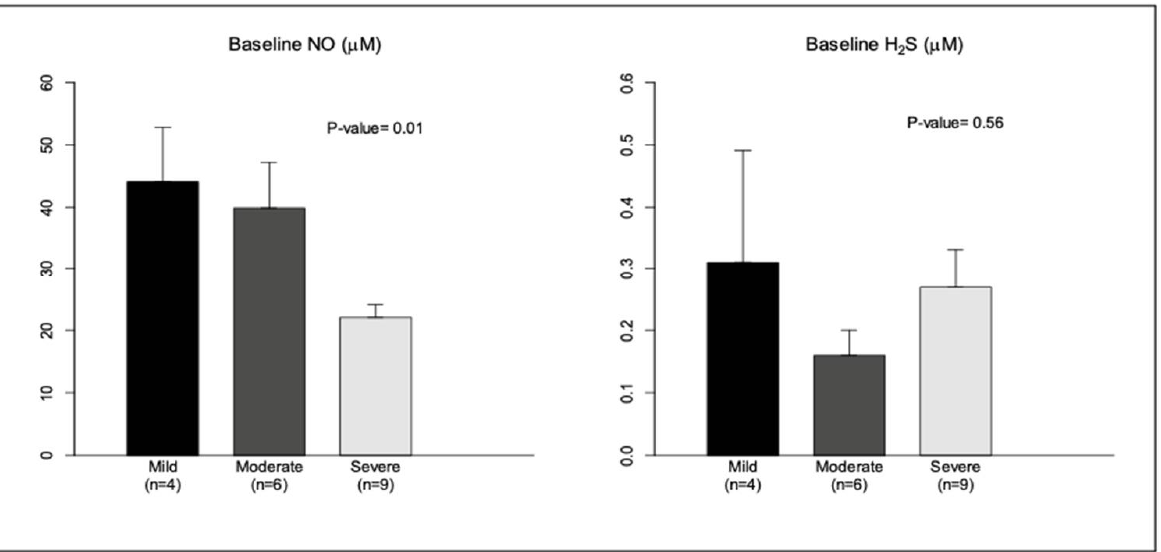
Figure 2. Baseline NO and H 2 S levels (in μM) were analyzed in relation to severity of OSA (AHI > 5/h). 1: Mild OSA (AHI 5–15/h); 2: moderate OSA (AHI 15–30/h); 3: severe OSA (AHI > 30/h). Data are shown as mean ± SE.